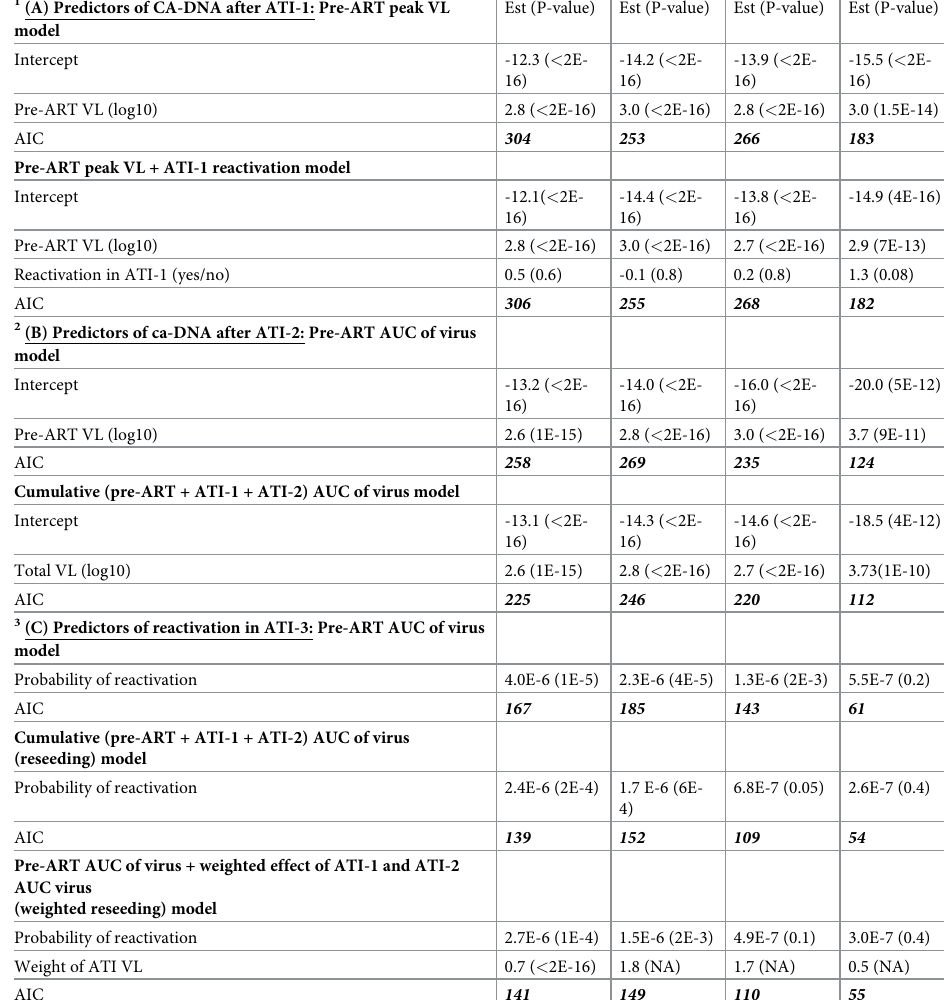
Table 2. Summary of estimated model parameters. 1 (A) Predictors of CA-DNA after ATI-1: Pre-ART peak VL model